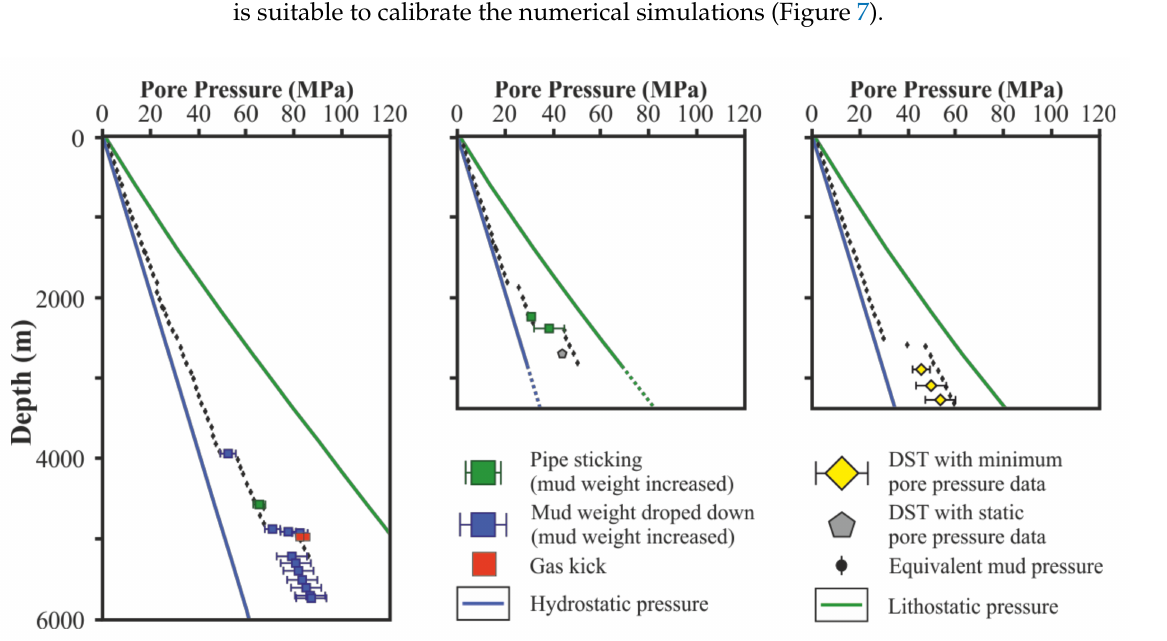
Figure 7. The most typical pore pressure proxies that have been used for the calibration of basin models. The overlapping intervals can delineate the most probable magnitude of the pore pressure. Mud weight drop is the process when the pore pressure exceeds the equivalent mud pressure (calculated from mud weight) and the pore fluids could enter into the borehole that lead to the dilution of the mud weight with less dense brines (mud weight drop down) or hydrocarbons (gas